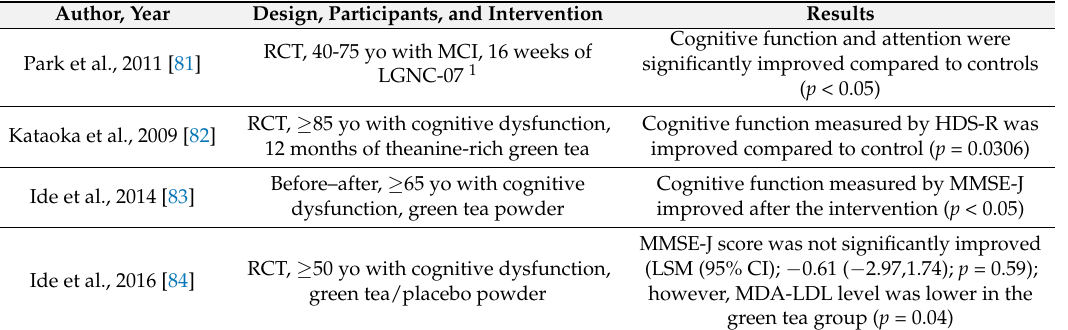
Table 2. Characteristics of interventional